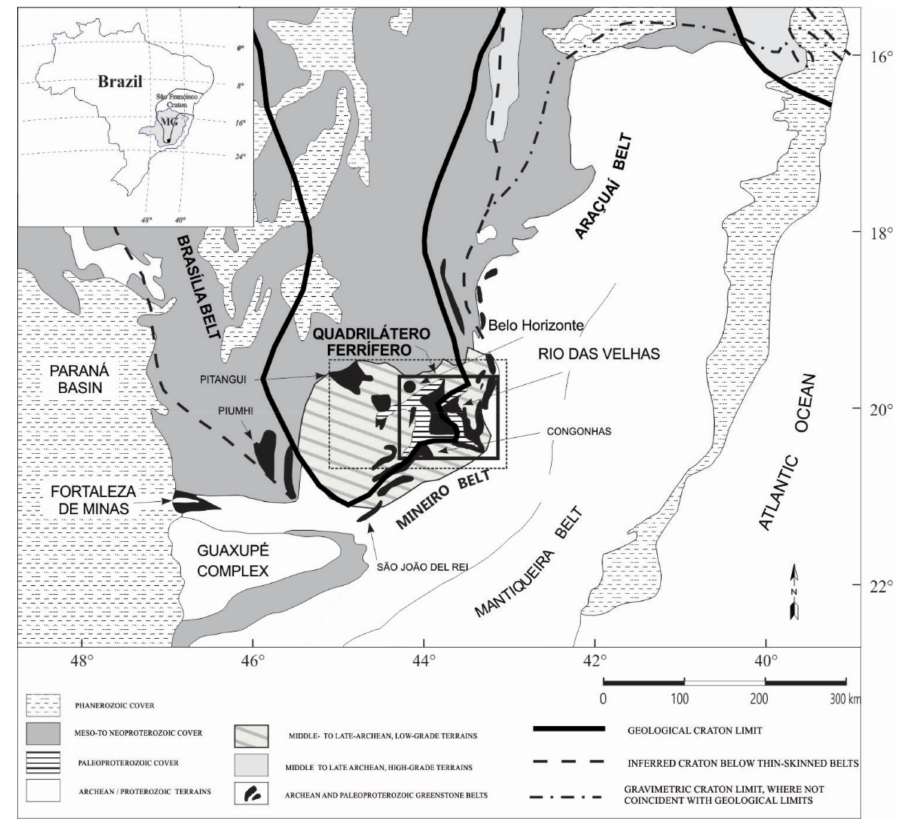
Figure 1. Regional geological map of the southern S ã o Francisco craton (modified from